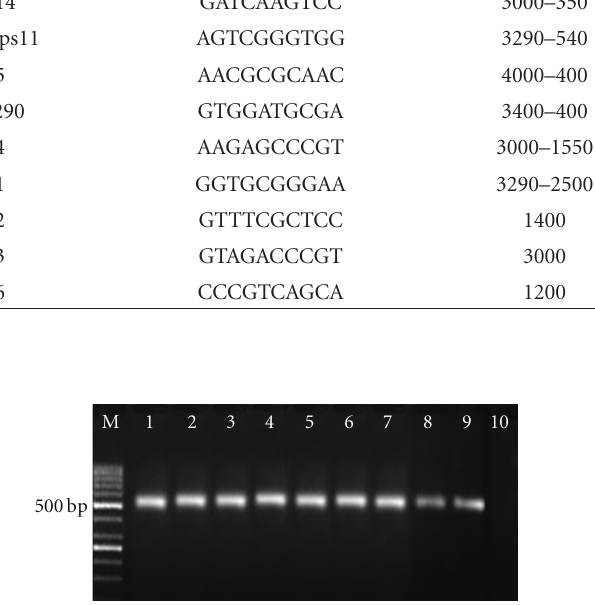
Figure 1: PCR product of S. iniae isolates obtained from diseased trout showing molecular weight of 513 bp on 2% agarose gel stained by Syber geen. M = marker, Lanes 1–8 = S. iniae isolates obtained from the diseased trout in Iran, Lane 9 = Positive control ( S. iniae ), Lane 10 = negative control ( L. gaarvieae